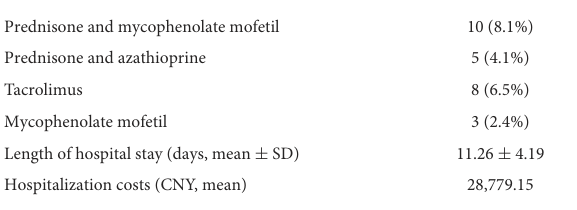
TABLE 1 Baseline clinical characteristics of patients with severe myasthenia gravis. Baseline